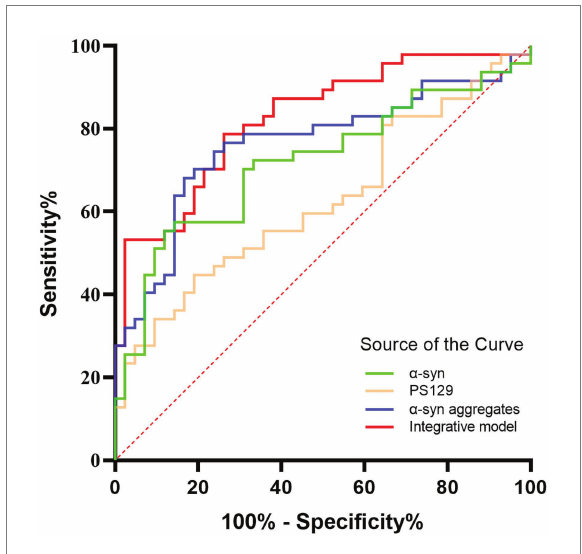
FIGURE 5 The ROC curves for α -Syn, pS129, α -Syn aggregates, and the integrative model. Green curve: α -Syn (AUC = 0.718); Yellow curve: pS129 (AUC = 0.625); Blue curve: α -Syn aggregates (AUC = 0.763); Red curve: the integrative model including α -Syn, pS129, and α -Syn aggregates (AUC =